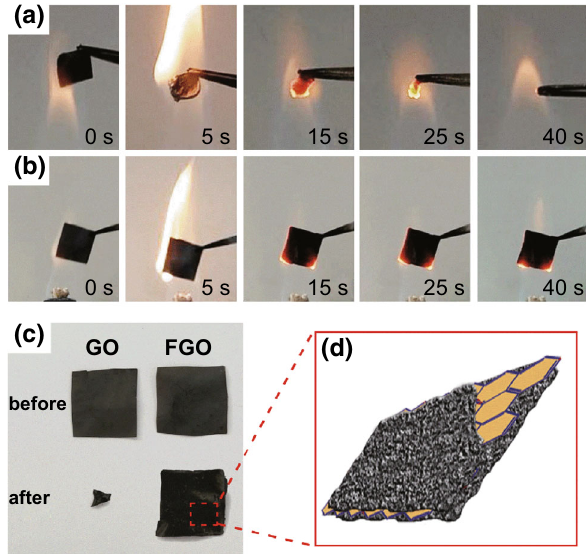
Fig. 10 Snapshots of flame treatment of PVA sheet coated with 30 LBL-assembled bilayers based on a GO and b FGO with respect to time in 40 s. c Photographs showing morphology of films before and after flame treatment. d Schematic diagram of char structure of FGO- based residue